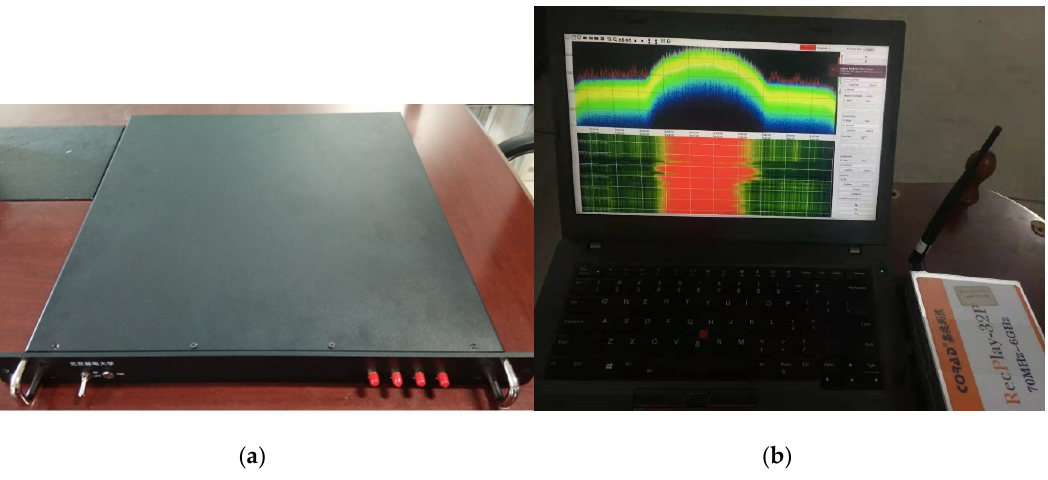
Figure 10. ( a ) FSBS positioning signal generator; ( b ) Signal collector.